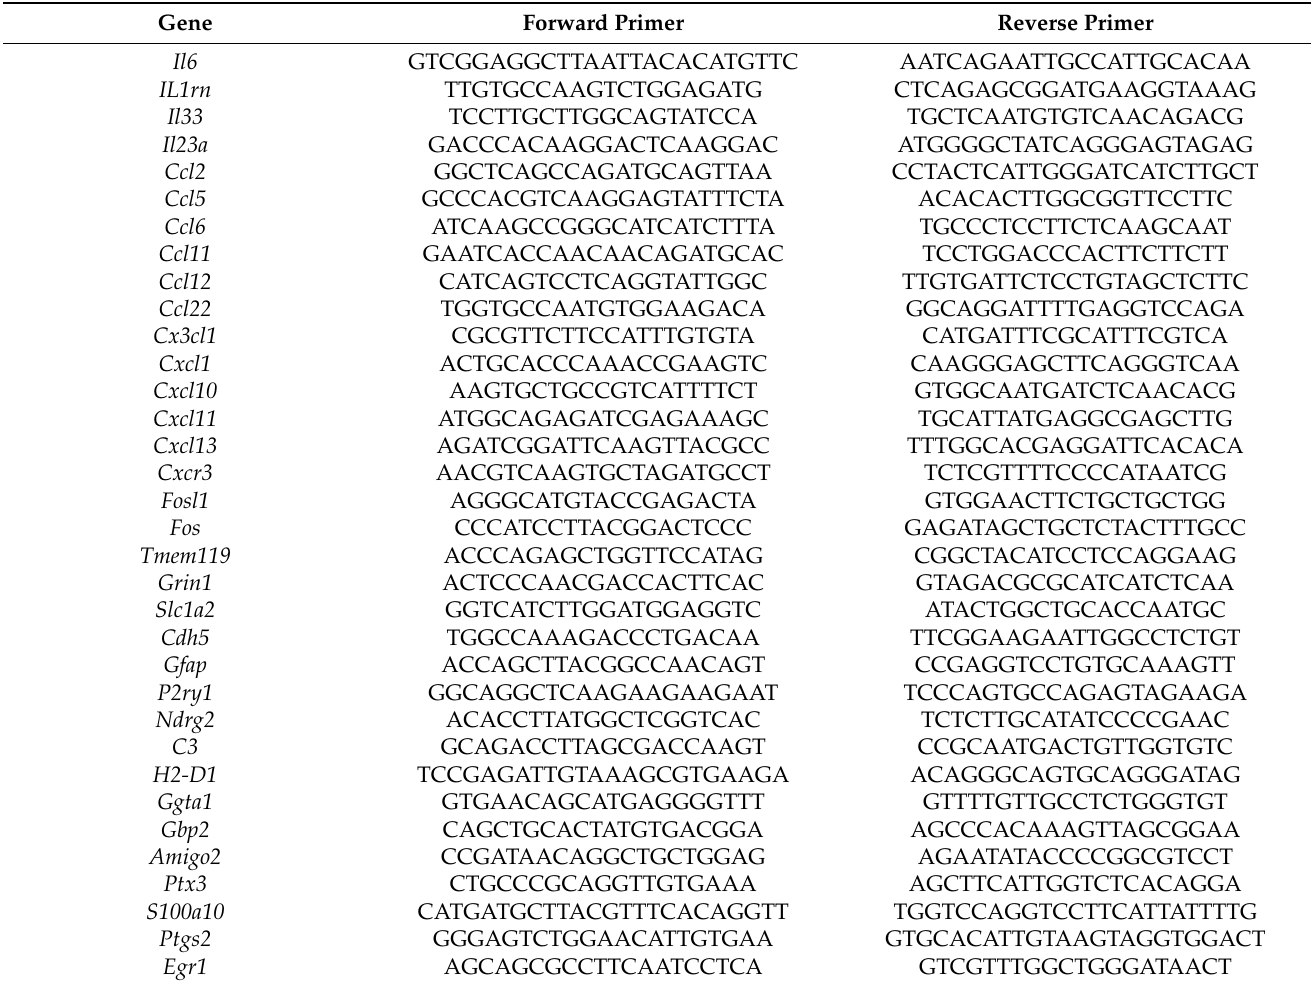
Table 1. Primer sequences used for real-time